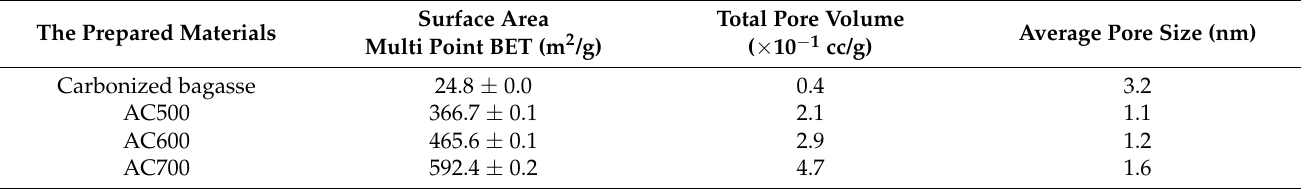
Table 2. Surface area (m 2 /g), total pore volume (cc/g), and the average pore size (nm) of the prepared samples. The Prepared